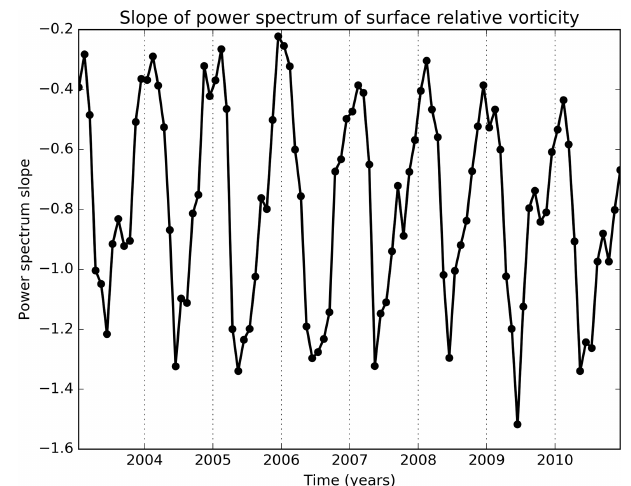
Figure 15. Time series of the regressed spectral slope from the power spectrum of surface relative vorticity from 2003 to 2010. Spectral slopes have been computed considering wavelengths from 7 to